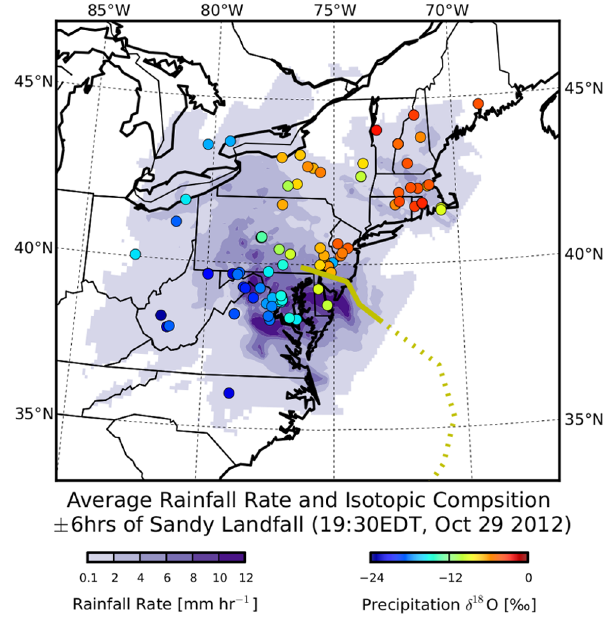
Figure 1. Snapshot of rainfall and d 18 O isotope values during landfall of Superstorm Sandy. Storm track has landfall + 6hrs as solid line.